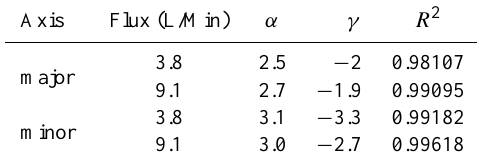
Fig. 7. Bubble size distributions for the major axis (left) minor axis (centre) and rise velocity distribution (right) for 3.8L/min and 9.1L/min. An increased gas flux yields increasing bubble numbers while the bubble size and rise velocity distribution remains constant. Note the single peaks at the cut off end of the distribution. These represent large bubble clusters. They are not well approximated by the model and are predominantly responsible for flux overestimation. Table 2. The gradients for the high and low flow distribution can be approximated using similarly valued parameters. This holds for the major axis as well as for the minor axis distribution in Fig.